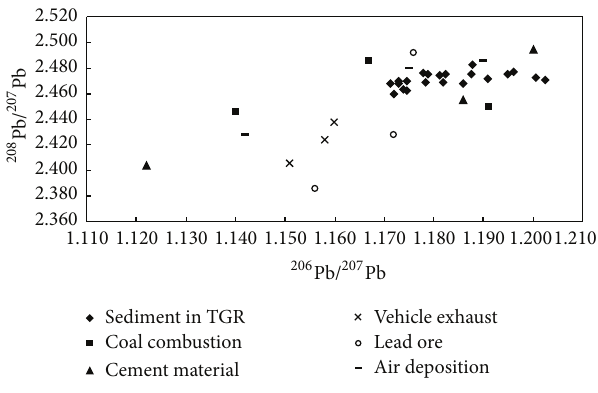
Figure 3: The distribution of Pb isotopic compositions in sediments from TGR and other environmental